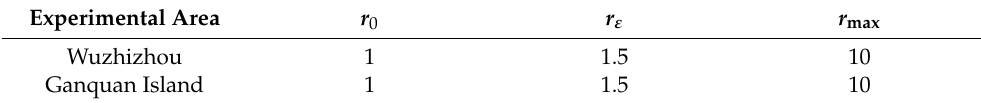
Table 4. Initial parameters for dimension-based selection of neighbor points in the